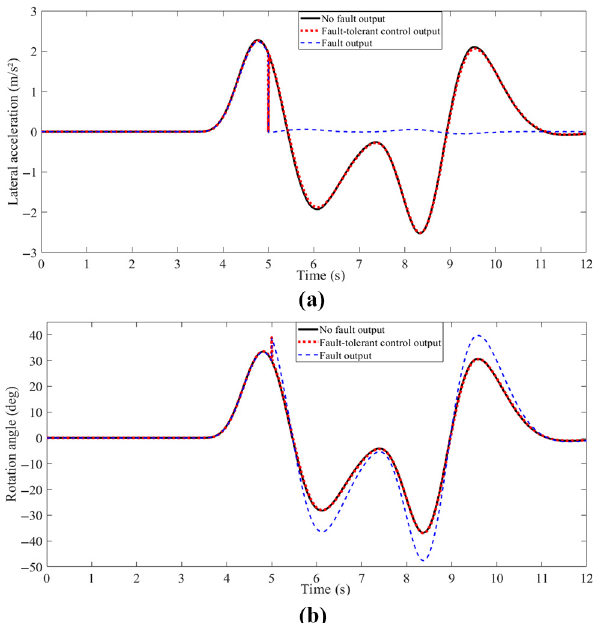
Figure 24 Simultaneous interruption-gain fault tolerant performance before and after comparison curves